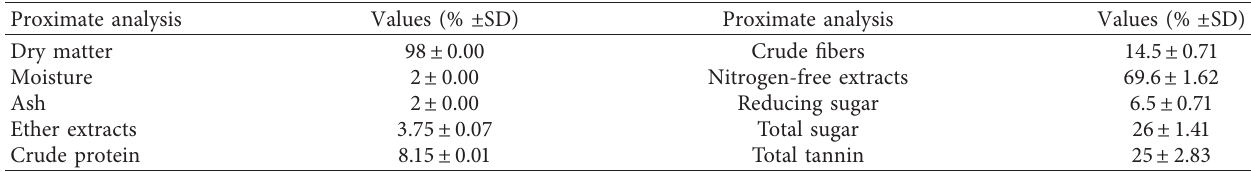
Figure 3: Effects of the ethanolic extract of Senna occidentalis (L.) roots part on glucose-loaded induced hyperglycemia in rats when compared within groups to fasting. Table 3: Physiochemical (proximate analysis) of Senna occidentalis root.